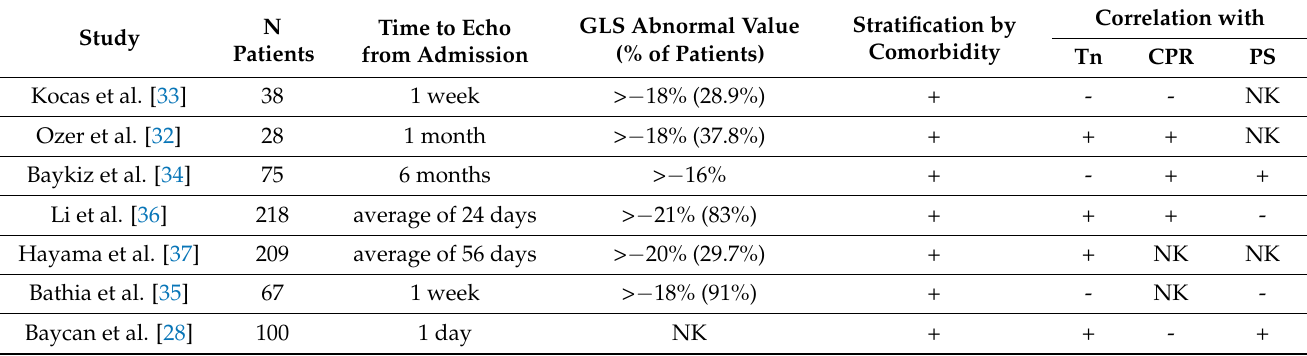
Table 1. Studies that assessed the correlation between LV-GLS and clinical and laboratory evaluations during COVID-19